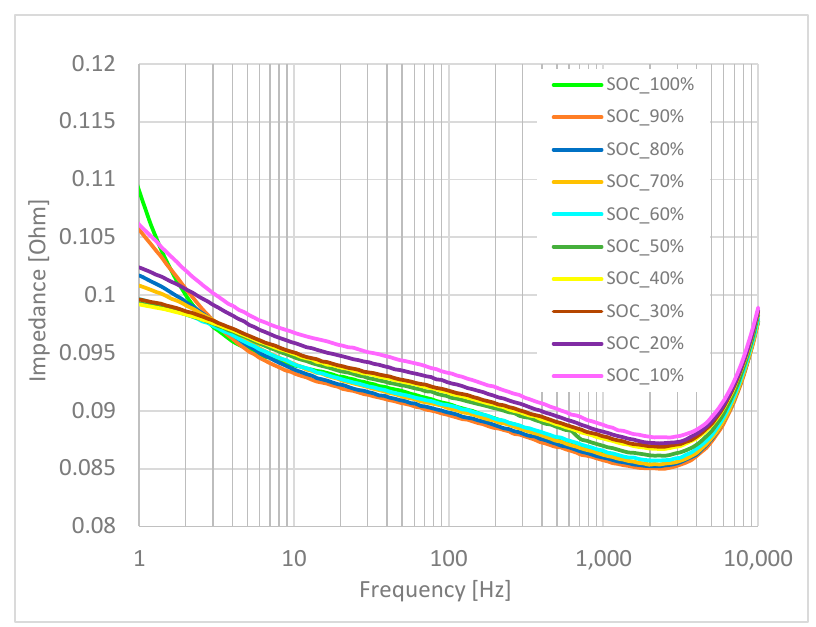
EIS measurements taken on the VSP potentiostat have shown that the frequency corresponding to the minimum impedance of all tested 18650 Li-Ion cells is 2.3 kHz for both SOC states: 100% and 10%, respectively. Minimum impedance values differ for each battery, starting from 0.0734 Ω (C2) up to 0.106 Ω (A2) in 100% SOC state, and from 0.076 Ω (C2) Figure 4. Impedance measurements: ( a ) at 100% SOC and ( b ) at 10% SOC. up to 0.124 Ω (A2) in 10% SOC, as seen in Figure 4. Impedance measurements taken at 10% SOC step clearly indicate that f Zmin does not Impedance measurements taken at 10% SOC step clearly indicate that f Zmin does not vary with SOC. According to [8], optimum pulsed discharge in terms of capacity took vary with SOC. According to [8], optimum pulsed discharge in terms of capacity took place at minimum impedance frequency; meanwhile, higher frequency values lead to an place at minimum impedance frequency; meanwhile, higher frequency values lead to an inferior response. In terms of practical applications (Figure 5), impedance variation in the inferior response. In terms of practical applications (Figure 5), impedance variation in the 1 kHz–3 kHz range can be considered quasi-constant (0.004 Ω variation). 1 kHz–3 kHz range can be considered quasi-constant (0.004 Ω variation).